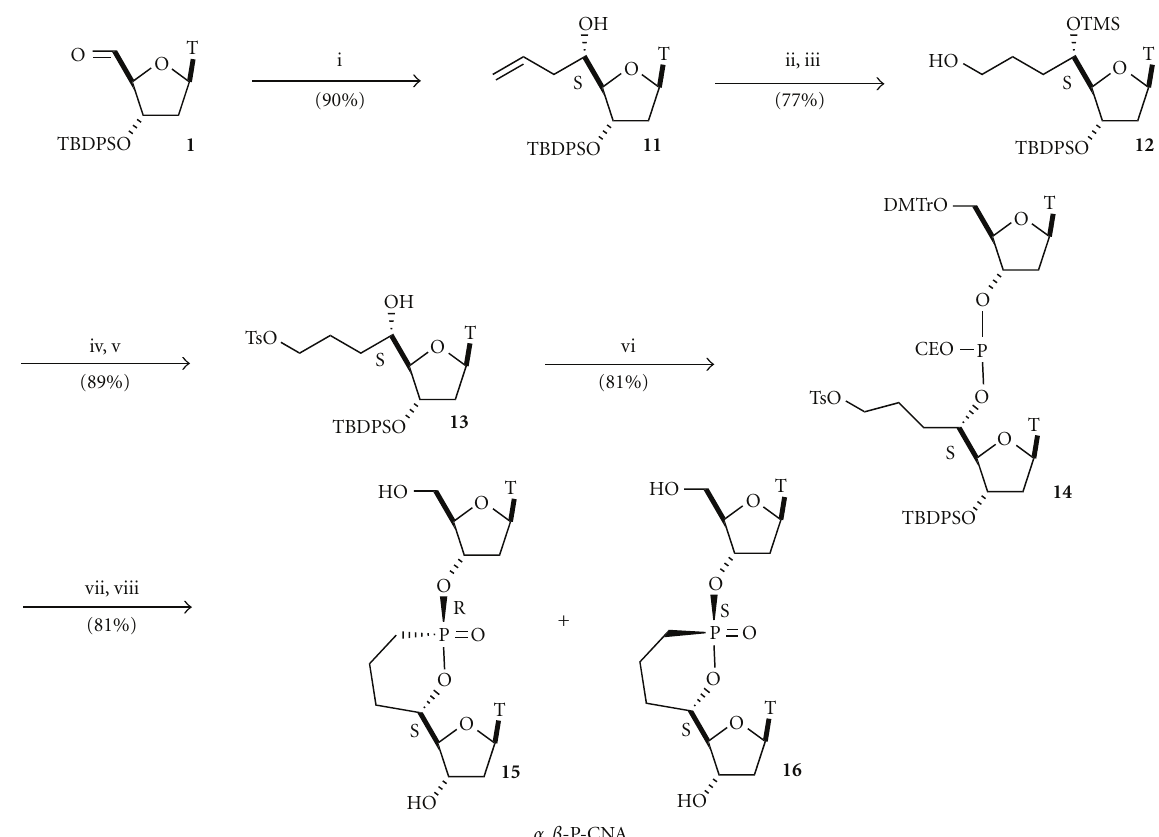
Scheme 2: Synthesis of α , β -Phostone-Constrained Nucleic Acid dinucleotides ( α , β -P-CNA). Reagents and conditions: (i) allyltrimethylsilane,